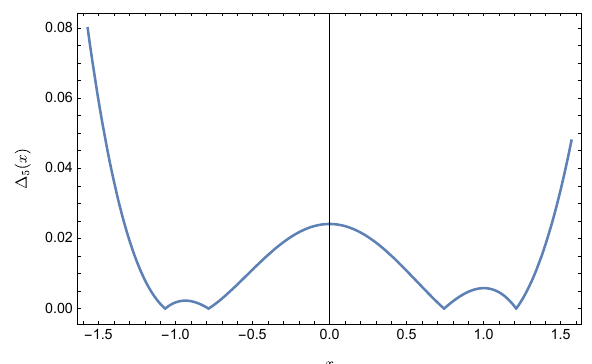
Figure 2. Error ∆ 5 of approximation y 5 ( x ) .